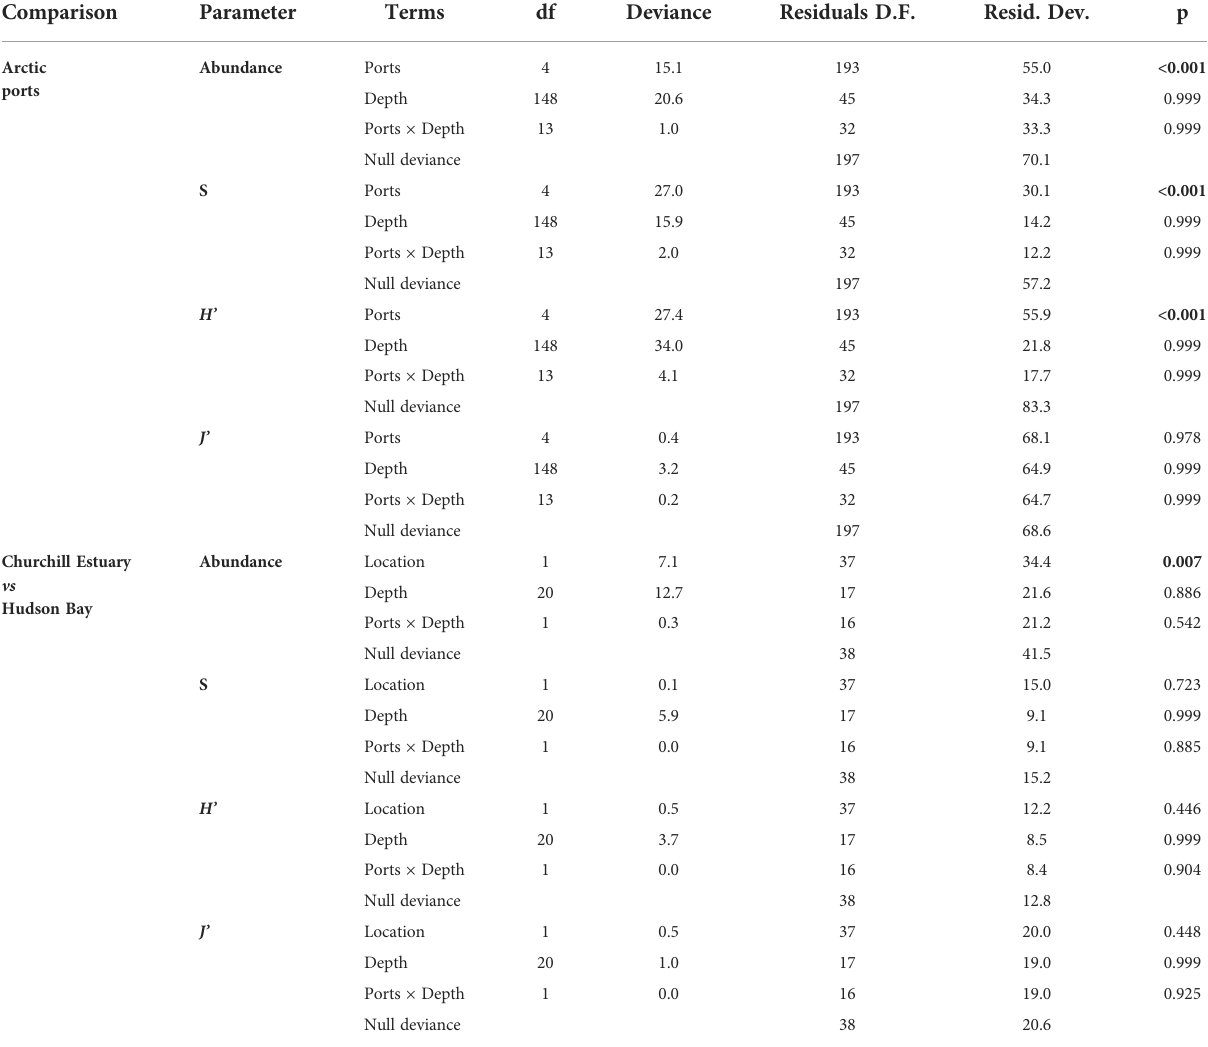
TABLE 2 Results of generalized linear models to examine the effect of ports and Churchill Estuary and Hudson Bay on the abundance (ind m -2 ), taxonomic richness ( S ), Shannon-Wiener diversity ( H ’ ), and Pielou ’ s evenness ( J ’ ).